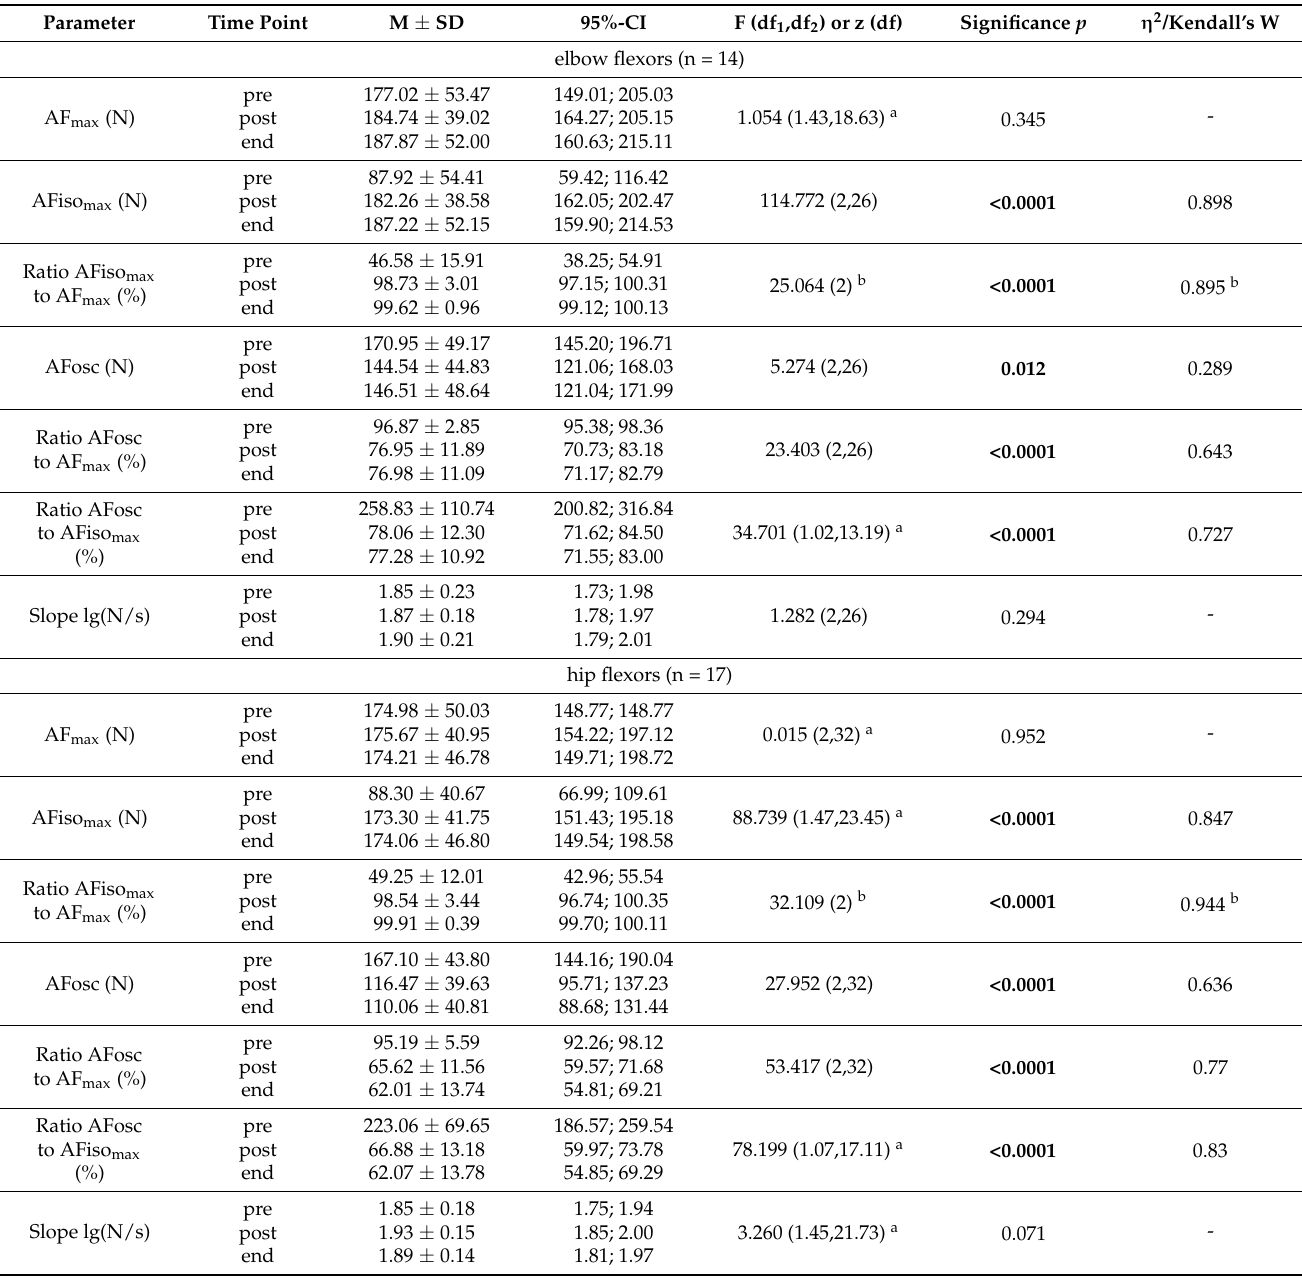
Table 2. Parameters of the Adaptive Force (AF) of elbow and hip flexors. Arithmetic means ± standard deviations (M ± SD), lower and upper borders of 95% confidence intervals (CIs) and values of the RM ANOVA (F-statistics, degrees of freedom (df), significance p and effect size η 2 ) or of the Friedman test (z, df, p , effect size Kendall’s W) are given for all AF parameters at each time point (pre: in long COVID state–before treatment, post: directly after treatment, end: recovery) of elbow (n = 14) and hip flexors (n = 17). Parameters: maximal AF (AF max ) (N), maximal isometric AF (AFiso max ) (N), ratio AFiso max to AF max (%), AF at onset of oscillations (AFosc) (N) and the ratios of AFosc to AF max (%) and AFosc to AFiso max (%), as well as the slope of force rise